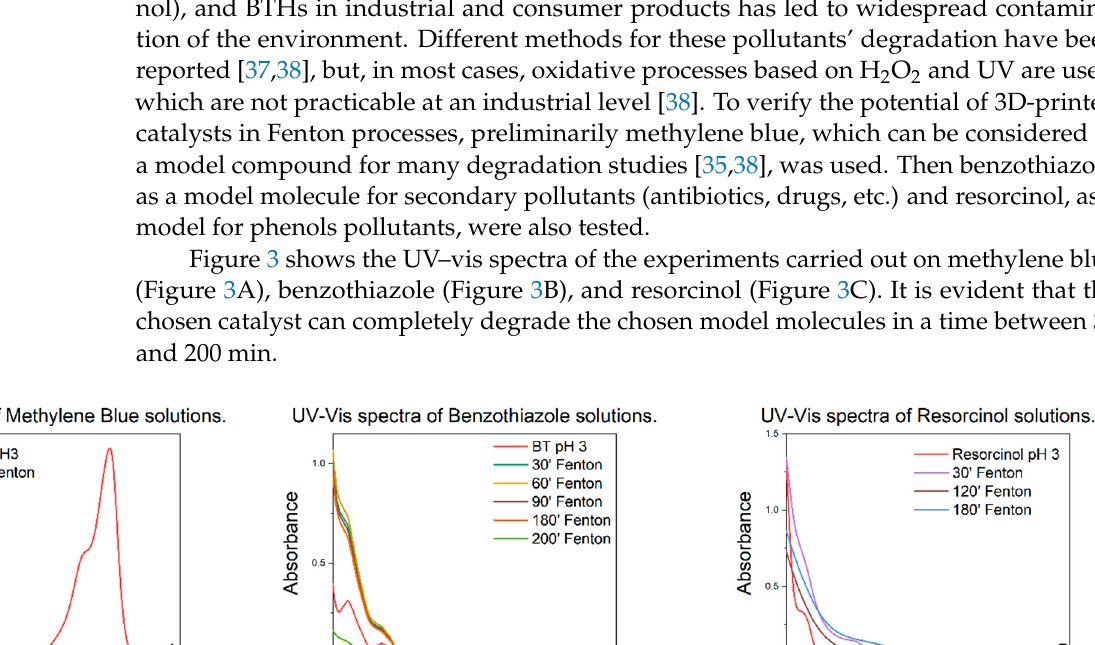
Table 2. Comparison of the efficiency of the 3D PLA catalyst with different results in the literature. Row #